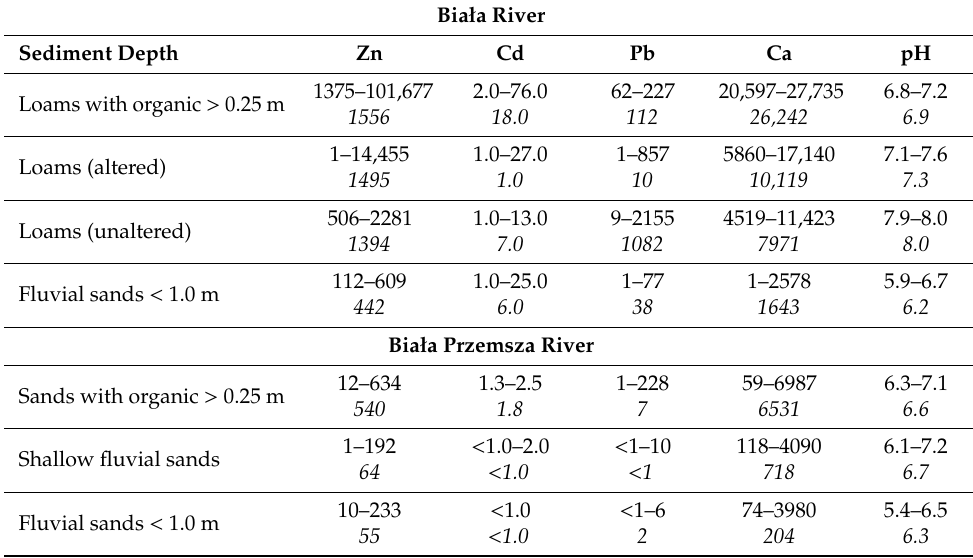
Table 2. pH and potentially most mobile metals in the sediments of the Biała and Biała Przemsza rivers. Range and median values in mg /